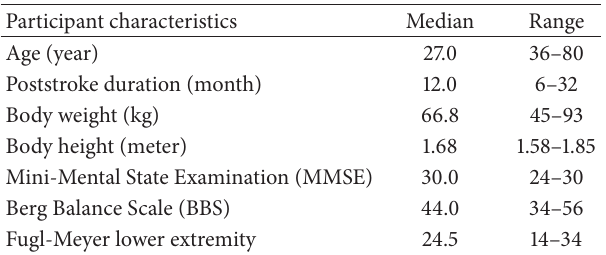
Table 1: General characteristics of stroke survivors and healthy control